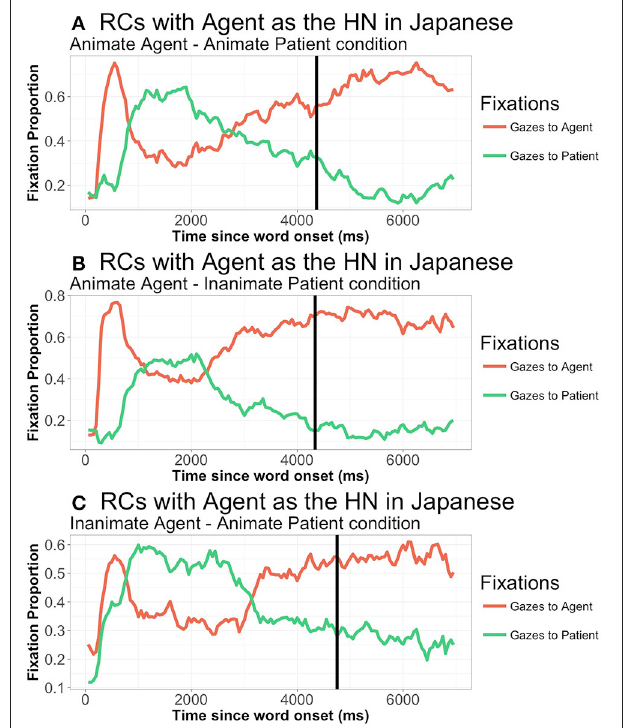
FIGURE 8 | Patterns of gazes to agent and patient in Japanese RCs when the agent was the HN, from picture onset until 7,000ms., in all three animacy combinations: (A) Animate agent—Animate patient; (B) Animate agent—Inanimate patient; (C) Inanimate agent—Animate patient. Similar pattern when patient was the HN, figures omitted. Vertical line represents speech